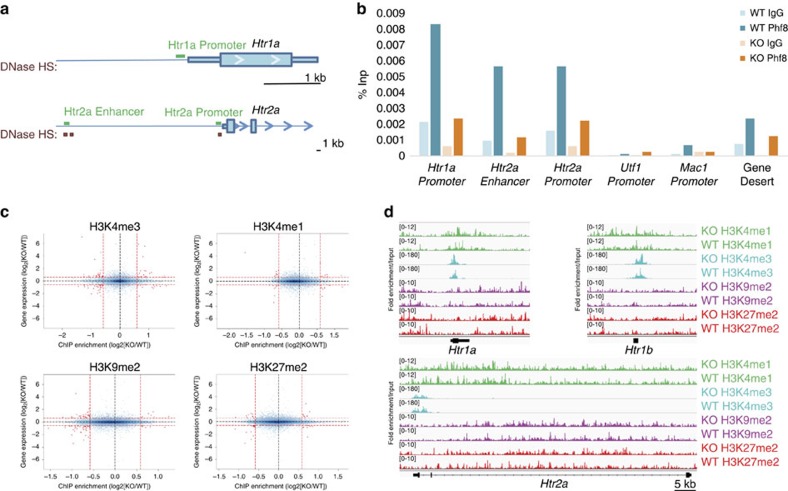
PHF8 directly regulates the serotonin receptors Htr1a and Htr2a.(a) ChIP primers (green bars) selected in promoter and putative enhancers of Htr1a, and Htr2a. Promoter-specific primers were designed in conserved regions within the first 300 bp of the TSS. Enhancer-specific primers were placed at conserved cerebral DNase hypersensitivity sites (HSs) (Red boxes; ENCODE/University of Washington) upstream of the TSS. For Htr2a a putative long range enhancer (∼40 kb) was selected, with Htr2a being the closest gene to this site and the next nearest gene being >100 kb away. (b) ChIP-qPCR on the neocortex with primers located in conserved regions either ∼200 bp upstream of the TSS (Promoter) or within a putative enhancer for the serotonin receptors. PHF8 occupancy is detected at the Htr1a and Htr2a loci but not at the promoter of Utf1, Mac1 nor within a gene desert. (c) Correlation between differential gene expression (y-axis; log2[KO/WT]) by RNA-seq and differential histone mark deposition (x-axis; log2[KO/WT]) at the TSS±3 kb when comparing WT and KO in neocortical neurons. (d) Input normalized reads show the fold enrichment of H3K4me1, H3K4me3, H3K9me2 and H3K27me2 at the serotonin receptors Htr1a, Htr1b and Htr2a.